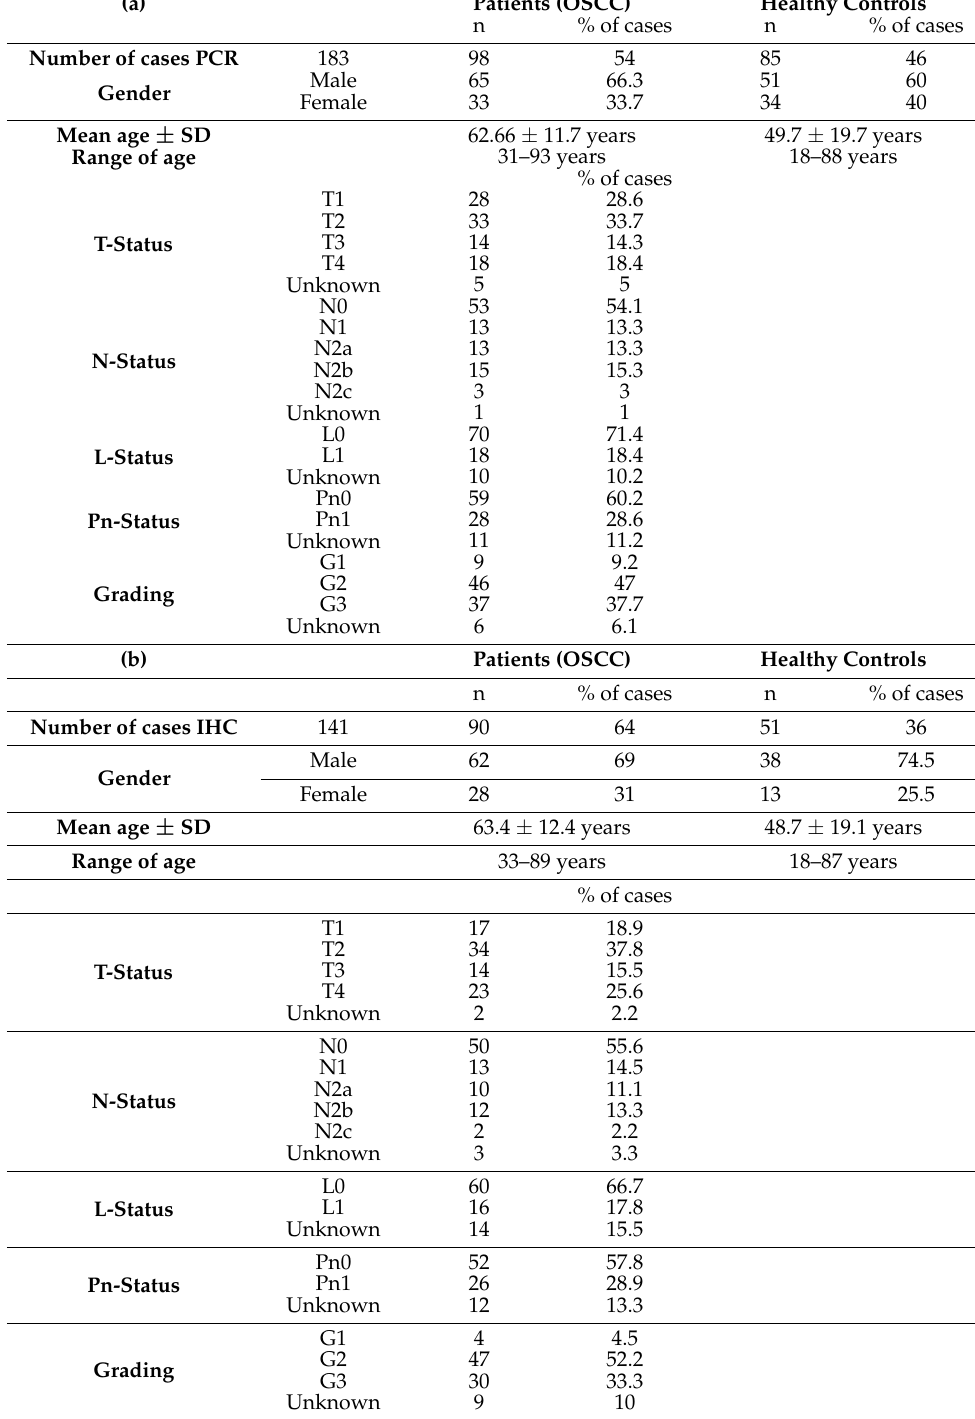
Table 1. Demographic characteristics of controls and OSCC patients. Demographic characteristics of healthy volunteers (control group) and OSCC patients (patient group) for CD96 analysis. For the patient group, parameters for, T-status, N-status, L-status, Pn-status, and grading are shown. For both OSCC and controls, group characteristics of gender, number of cases, and age are shown. Exact data for RT-qPCR (a) and immunohistochemistry (b) analyses are given.